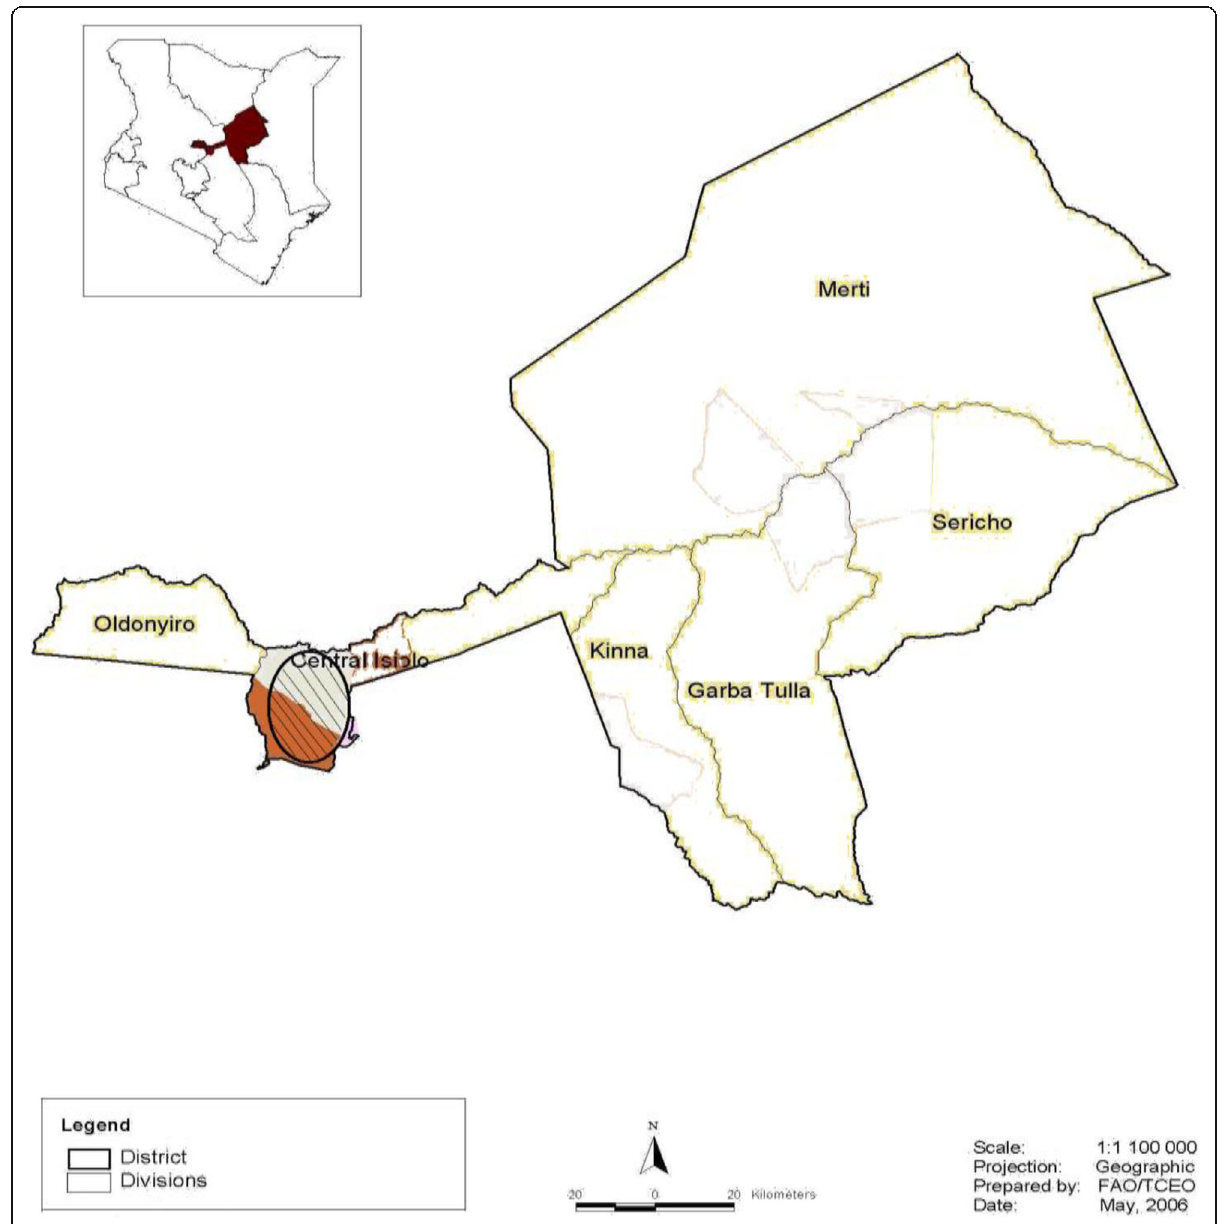
Figure 1 A Map of Isiolo County showing (Circled region is Isiolo